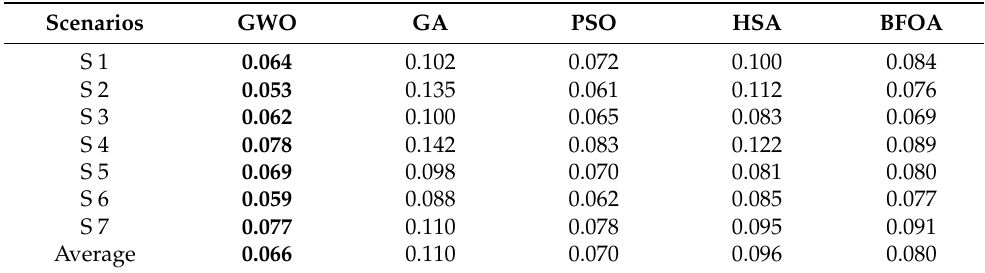
Table 15. Comparison between the five algorithms in terms of WTR reduction. Scenarios